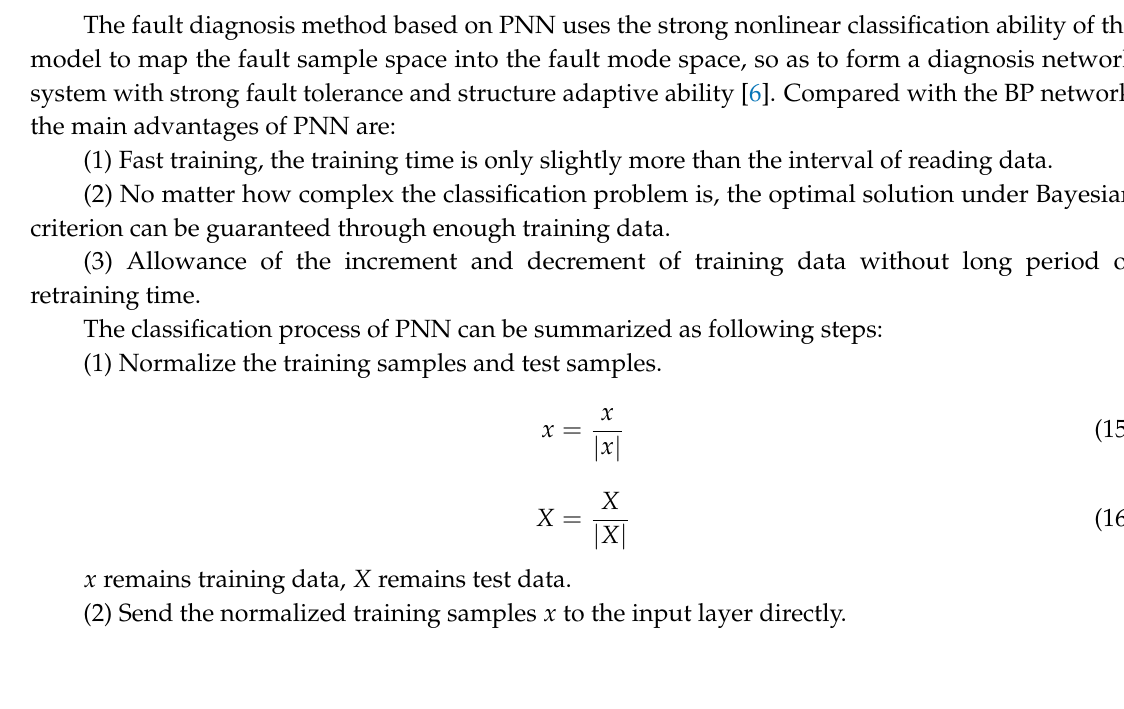
Figure 7. The structure of Probabilistic neural network.